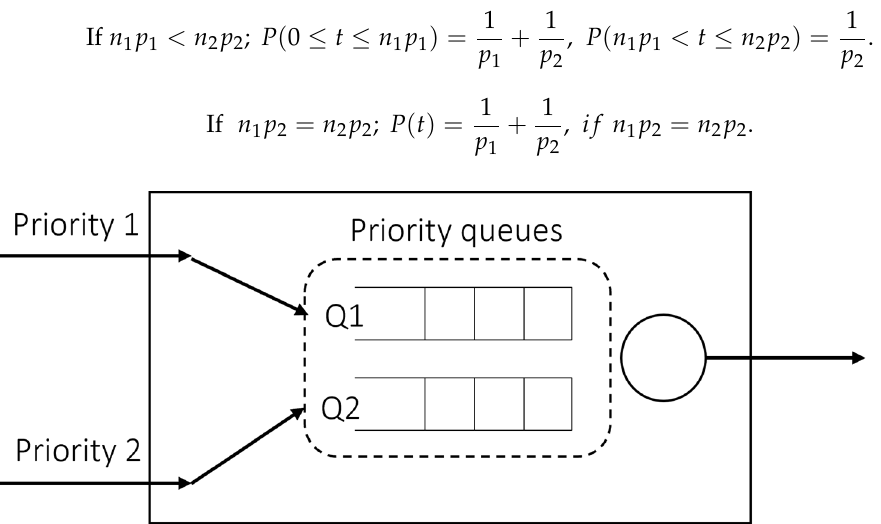
Figure 3. The output port structure of the network that is prepared for DDQN training in this study. In the training DDQN environment, there is a single node with two input ports to priority queues and one output port. Table 2. Probability of meeting the deadline of each priority in